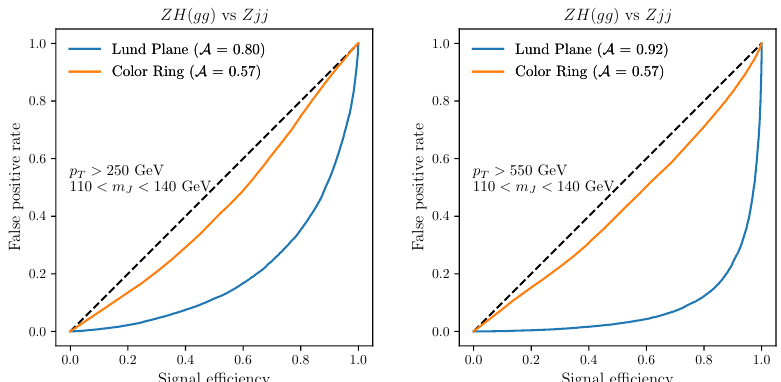
Figure 4: CNN (used for the Lund jet plane images) and color ring ROC curves for the H → g g analysis [ 3 ]